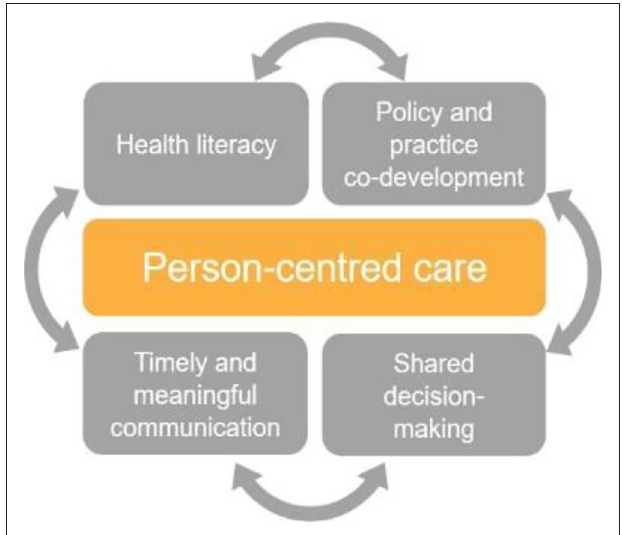
FIGURE 1 | Key features of person-centered care.